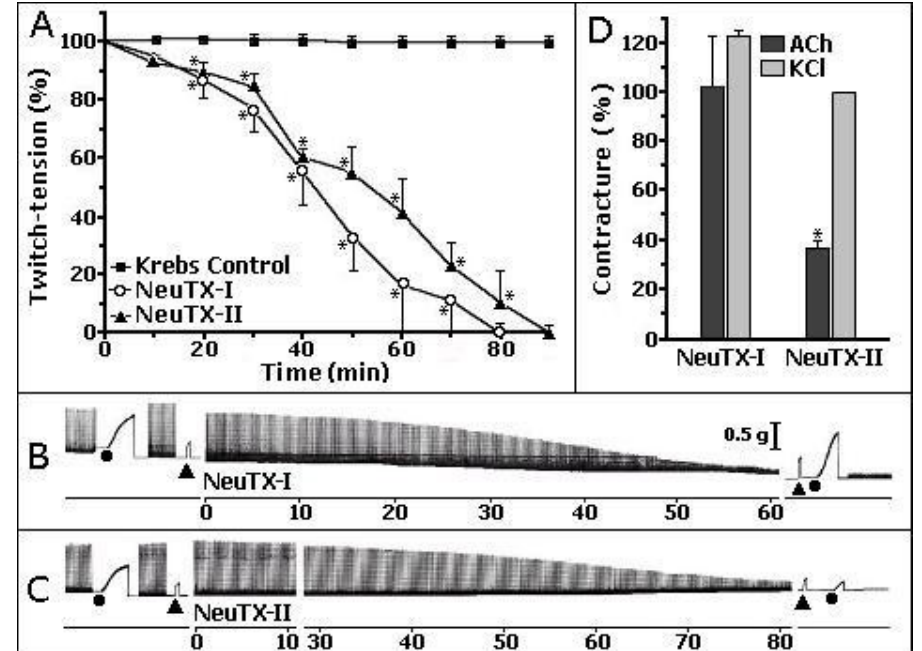
Figure 2. Neuromuscular blockade of chick biventer cervicis preparations at 37 ° C by NeuTXs-I and II. A: Time-dependent blockade produced by each toxin (10 μ g/ml), on indirectly stimulated preparations, compared to the Krebs control (* p <0.05). Each point represents the mean ± S.E.M. of 3-5 experiments. B and C: Representative recordings of the responses of indirectly stimulated chick preparation to NeuTX-I and NeuTX-II (10 μ g/ml), respectively. Responses to exogenous acetylcholine ( ▲ , 110 μ M) and KCl ( (cid:32) , 13.4mM) were obtained before and after the addition of toxins. Note that, in contrast to the response to KCl, response to acetylcholine after the blockade by NeuTX-II was still identical to the control. This result is representative of 3 experiments. D: Muscle contractures to KCl (13.4mM) and acetylcholine (ACh, 110 μ M) after 120min incubation with each toxin (10 μ g/ml) (mean ± S.E.M. of 3-5 experiments), expressed as a percentage of the pre-toxin values (* p